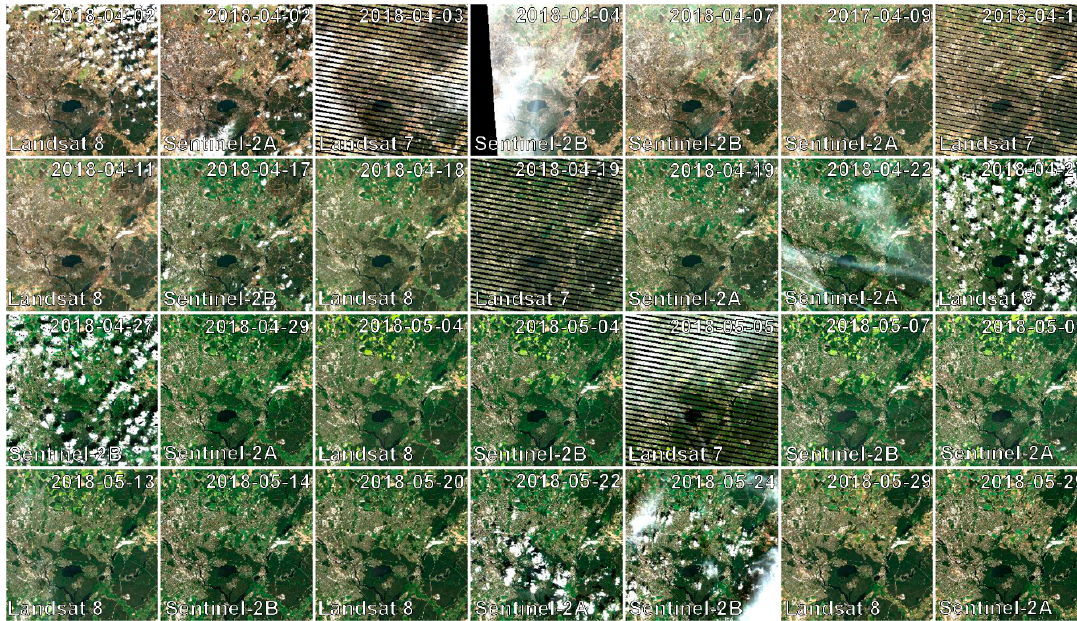
Figure 5. Data cube of Landsat 7/8 and Sentinel-2 A/B Level 2 ARD for Southeast Berlin, Germany. A two-month period of true color image chips for one 30 × 30 km tile is shown.